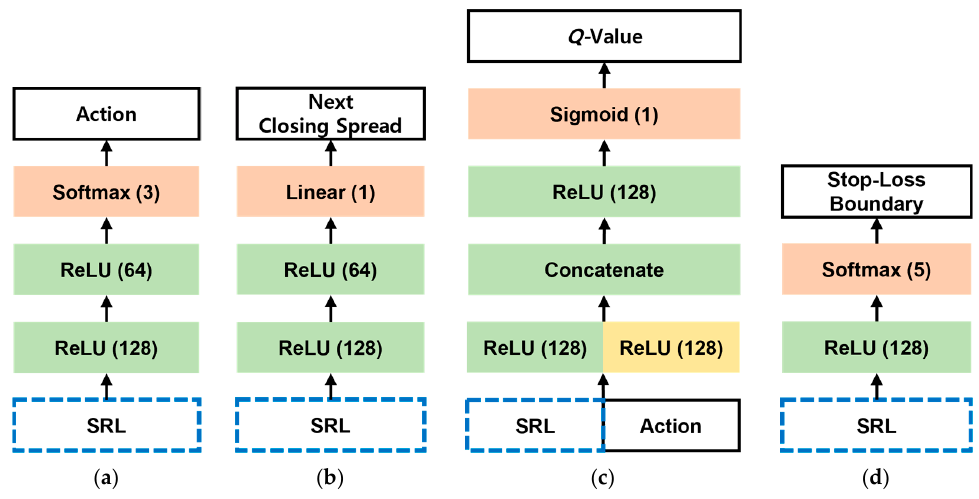
Figure 8. Neural network structures. ( a ) Actor. ( b ) Regression. ( c ) Critics. ( d ) Stop-Loss.